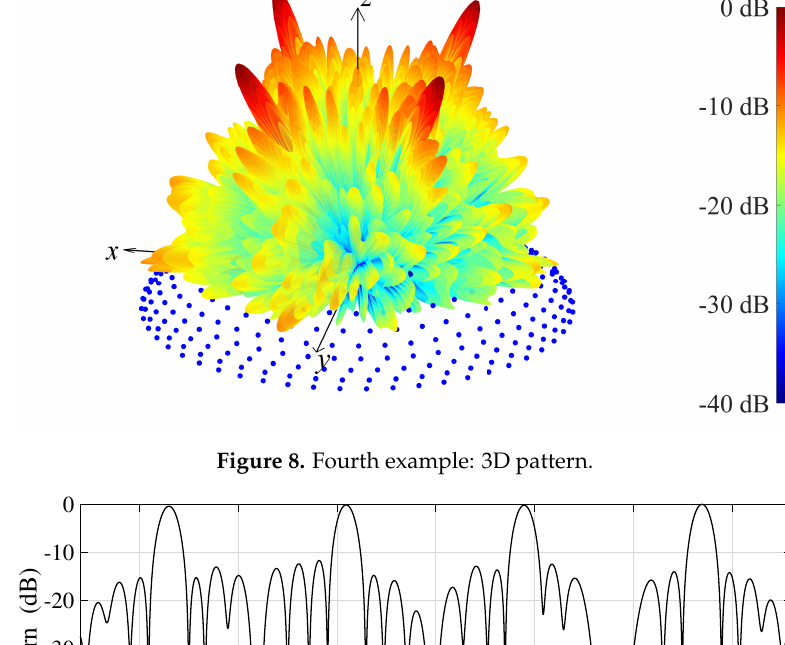
Figure 8. Fourth example: 3D pattern.